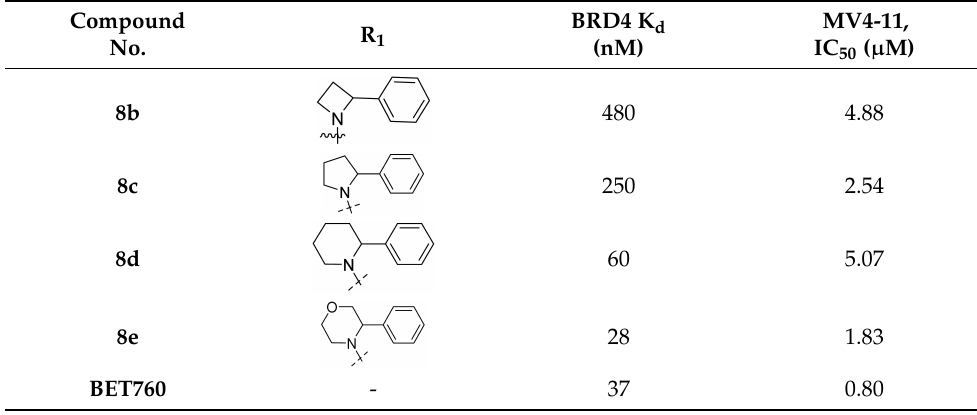
Figure 9. Structure of quinazoline phenyl morpholine based hybrids and the most promising com ‐ pound 8a. Table 7. In vitro cytotoxic activities of hybrid compounds 8 ( b – e ).